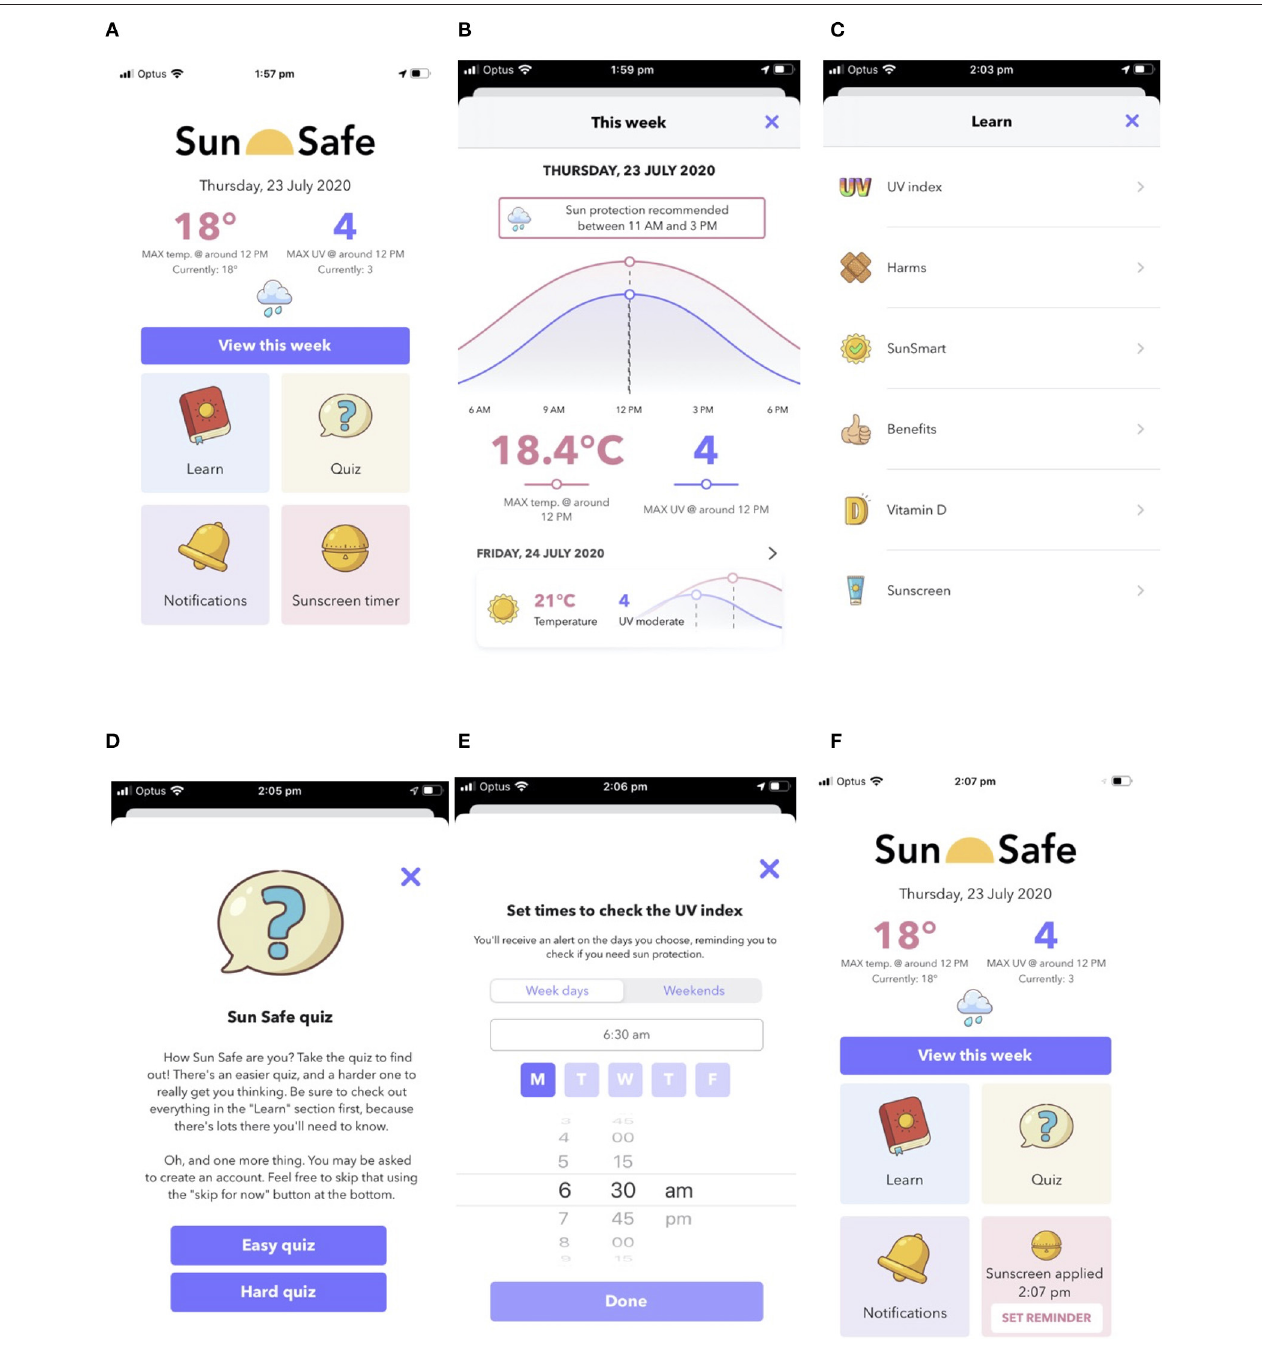
FIGURE 7 | Screenshots of the fully functional Sun Safe app to be tested in intervention studies. Features of the app included: (A) home page with that day’s maximal temperature and UV Index and access to other features; (B) more detailed predictive data on the maximal temperature and UV Index linked to times when to use sun protection for that day and subsequent days, accessed through “View this week” button; (C) educational content in “Learn” feature; (D) “Easy” and “Hard” quizzes in “Quiz” feature; (E) capacity to set daily “Notifications” to check the UV Index; and (F) capacity to set a “Sunscreen Reminder” (through “SET REMINDER” button) for up to 2h from when sunscreen is first applied, with a notification sent to reapply. males, although fewer male co-researchers were lost to